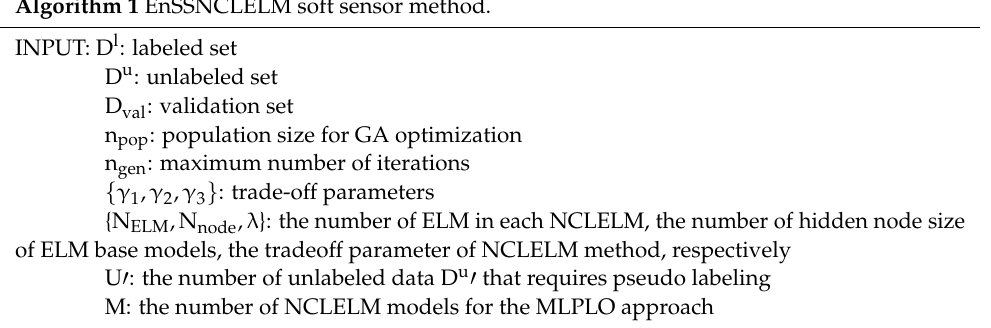
Algorithm 1 EnSSNCLELM soft sensor